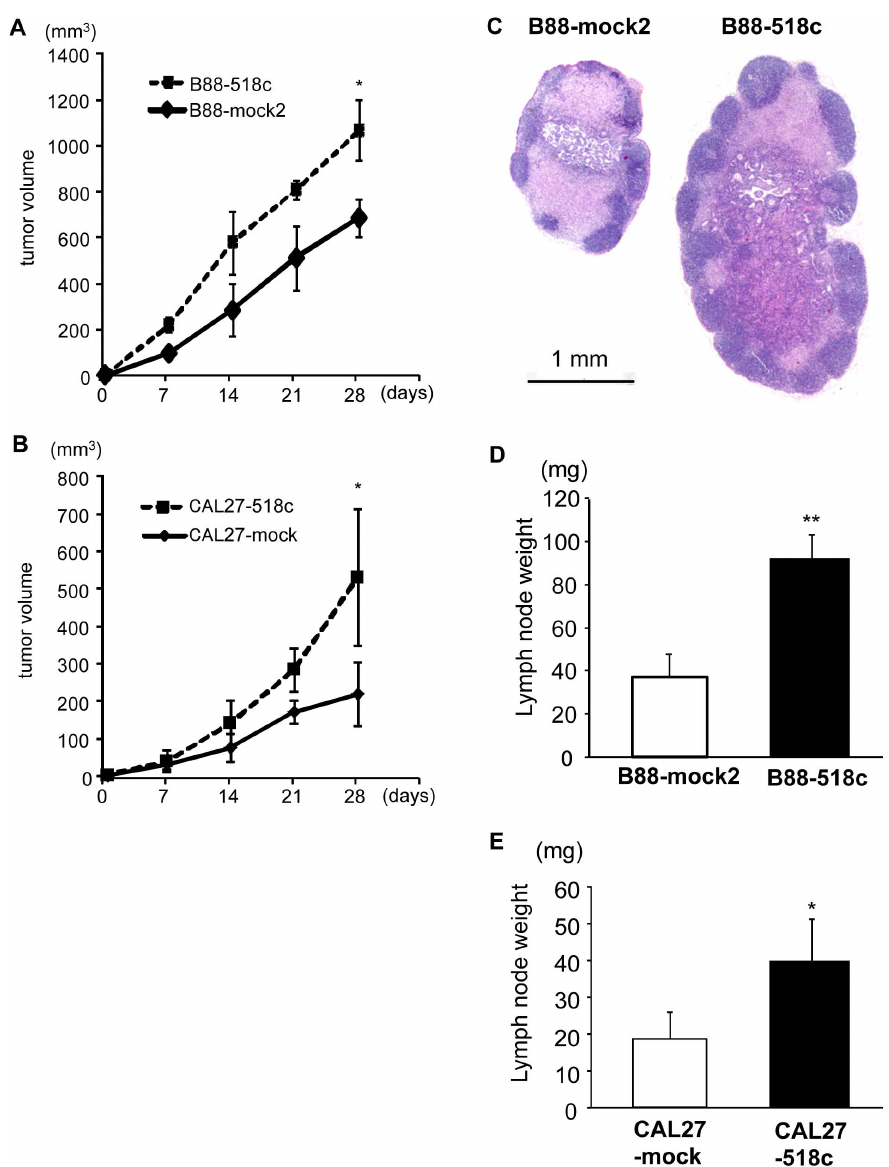
Fig. 5. The enhancement of tumor growth and lymph node metastasis in miR-518c transfectants. (A, B) B88-transfectants (A) and CAL27-transfectants (B) were orthotopically inoculated into the masseter muscle of nude mice, which were sacrificed at day 35. The size of primary tumors was measured once a week. The results presented are the means ¡ SD. *; p , 0.05 when compared to mock cells by one-way ANOVA. (C) Representative H&E staining of the metastatic lymph nodes from the nude mice inoculated with B88-mock2 cells (left) and B88-518c cells (right). (D, E) The weight of the submandibular lymph nodes was measured in the mice inoculated with B88-transfectants (D) and CAL27-transfectants (E). *; p , 0.05 when compared to mock cells by one-way